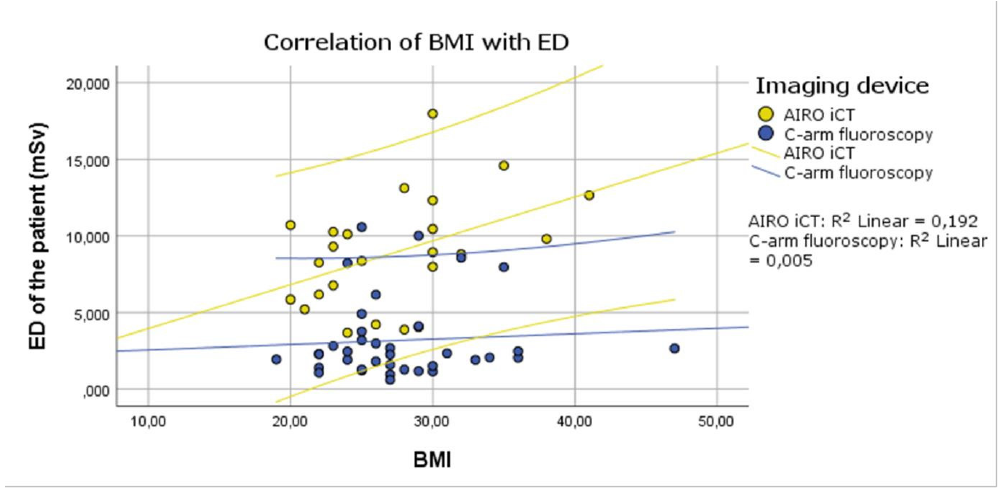
Figure 6. Spearman’s correlation between BMI and the effective dose of the patient. Correlation analysis of the BMI and the ED of patients who had an MI-PLIF surgery assisted by iCT ( n = 24) (R 2 = 0.192, p < 0.05) or C-arm fluoroscopy ( n = 37) (R 2 = 0.005, p > 0.05). The lines delineate a 95% confidence interval per subgroup.